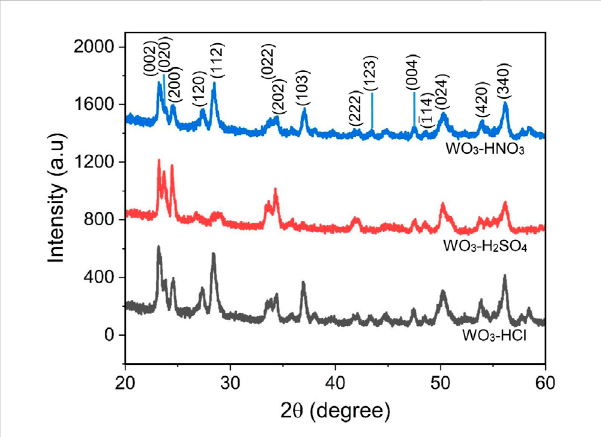
FIGURE 1 X-ray diffraction patterns of WO 3 synthesized using three different acids- HNO 3 , H 2 SO 4 , and HCl — for